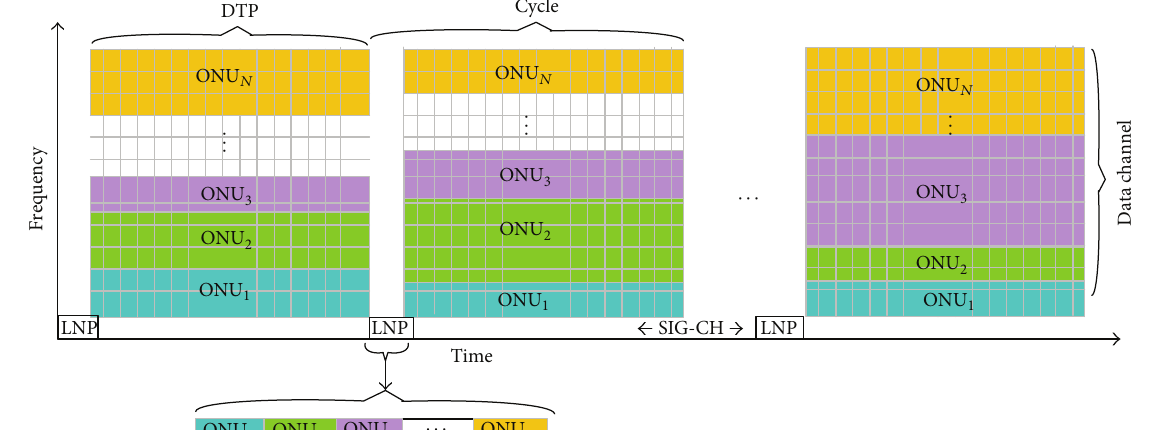
Figure 6: Channel assignment.